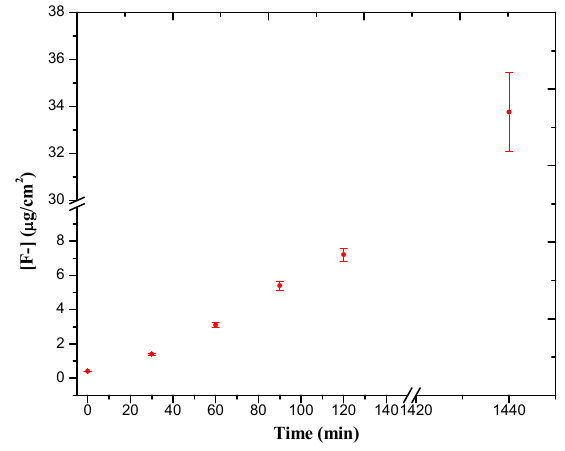
Figure 13. Fluoride ions released of PEO coating for 120 min.